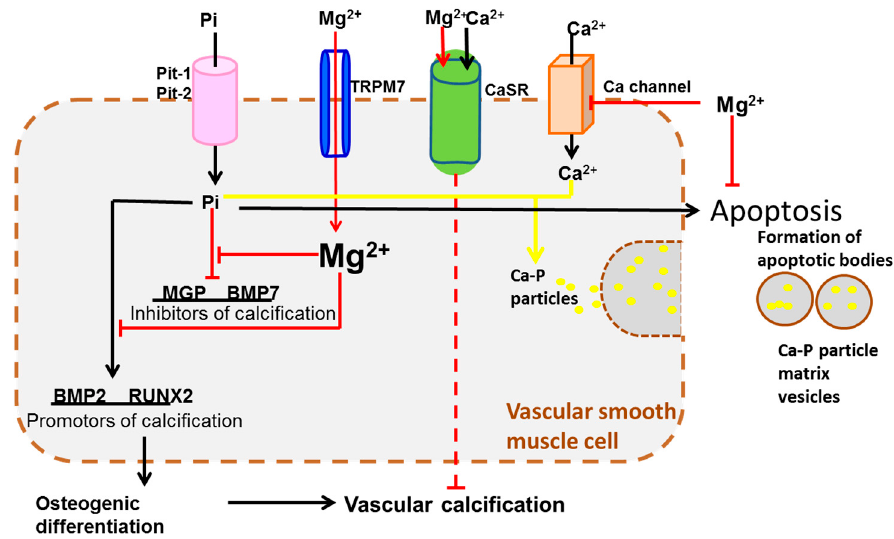
Figure 2. Mg 2+ interferes with calcium homeostasis and Ca-P layer deposition. Abbreviations: Pit, inorganic phosphate transporter; MGP, matrix Gla protein; BMP, bone morphogenetic protein; RUNX2, runt-related transcription factor 2.